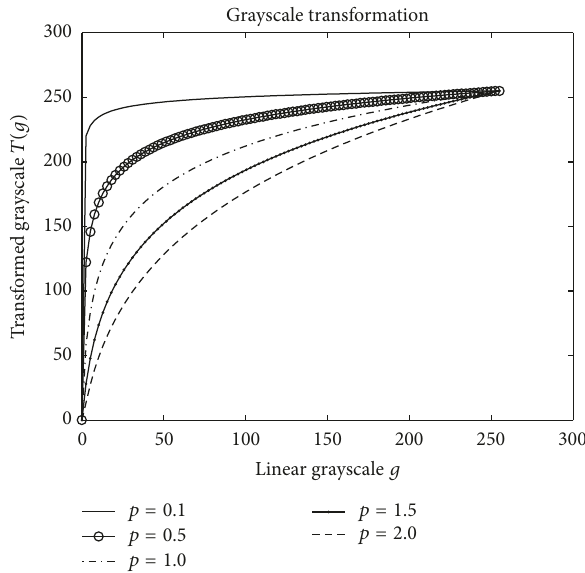
Figure 10: Gray Level Transformation using different 𝑝